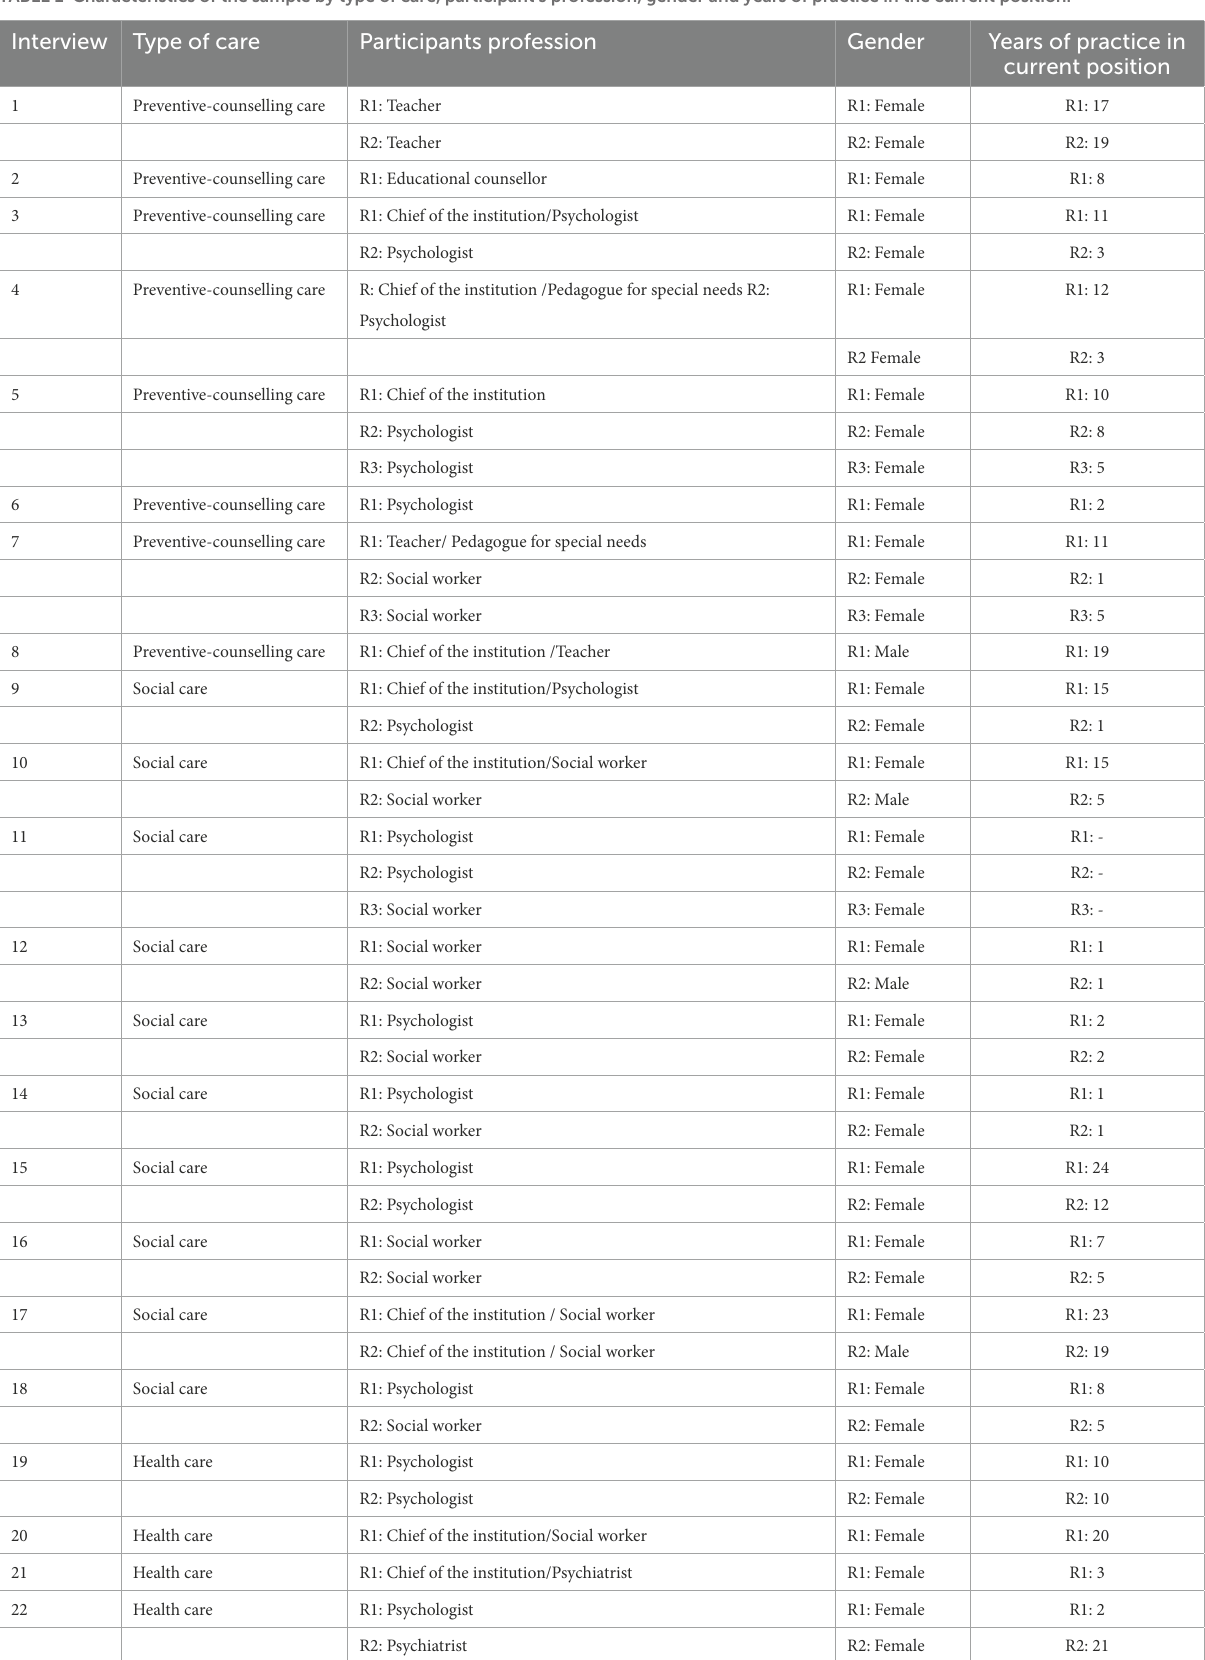
TABLE 1 Characteristics of the sample by type of care, participant’s profession, gender and years of practice in the current position. Interview Type of care Participants profession Years of practice in